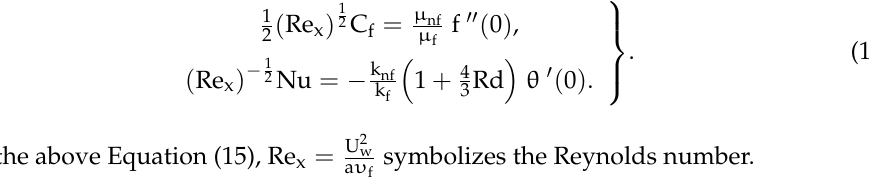
Figure 3. Variation of C (cid:2916) with λ (cid:2870) .